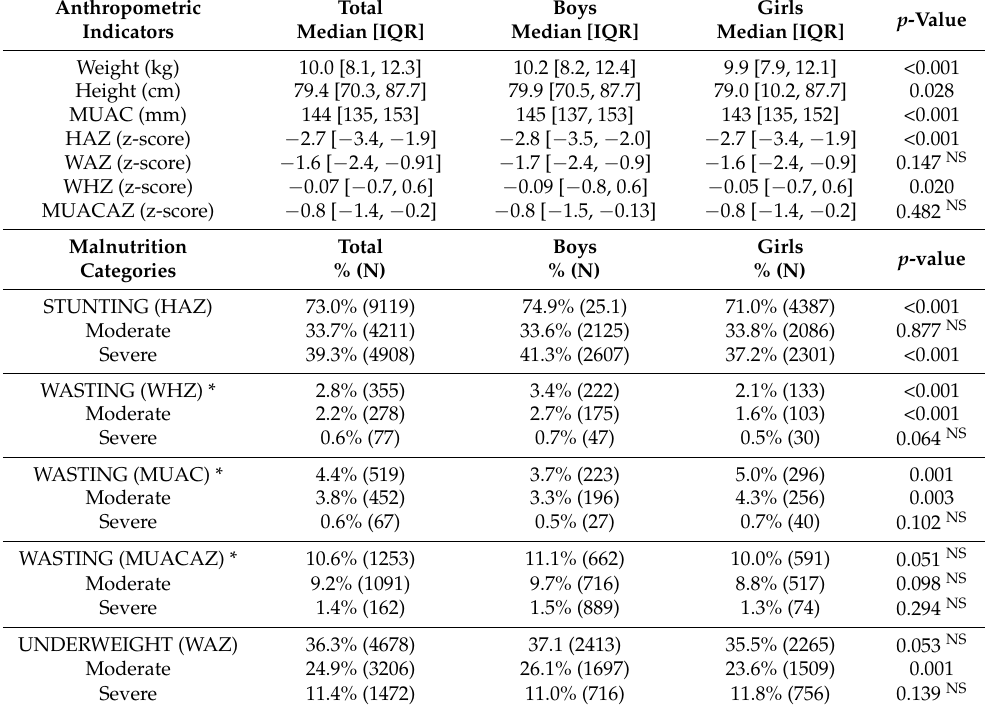
Table 1. Anthropometric indicators and prevalence of the different types of undernutrition by sex. Anthropometric